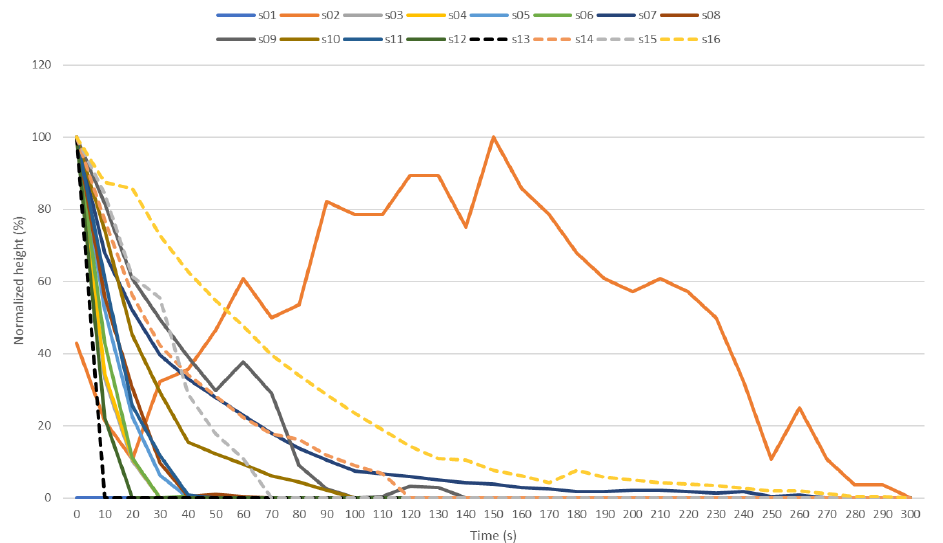
Figure 5. Normalized foam height (%) determined by performing image analysis on RGB videos of 16 beer samples.